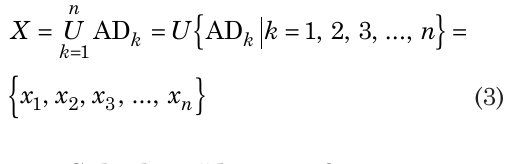
) 0 a1.1 total green space area a1.2 landscape continuity a1.3 Distance between green spaces a1.4 Green space shape